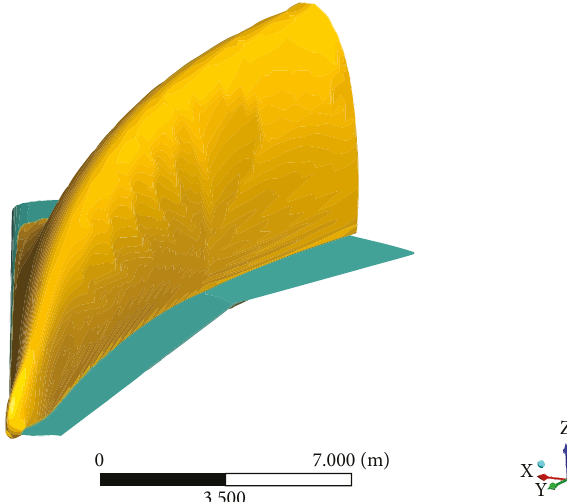
Table 1: CFD results for swept-wing and curved-wing models